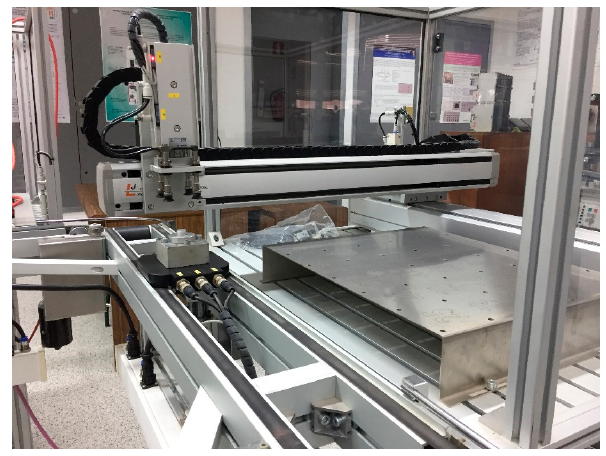
Figure 4. Station FMS-207: Robotized screwing.